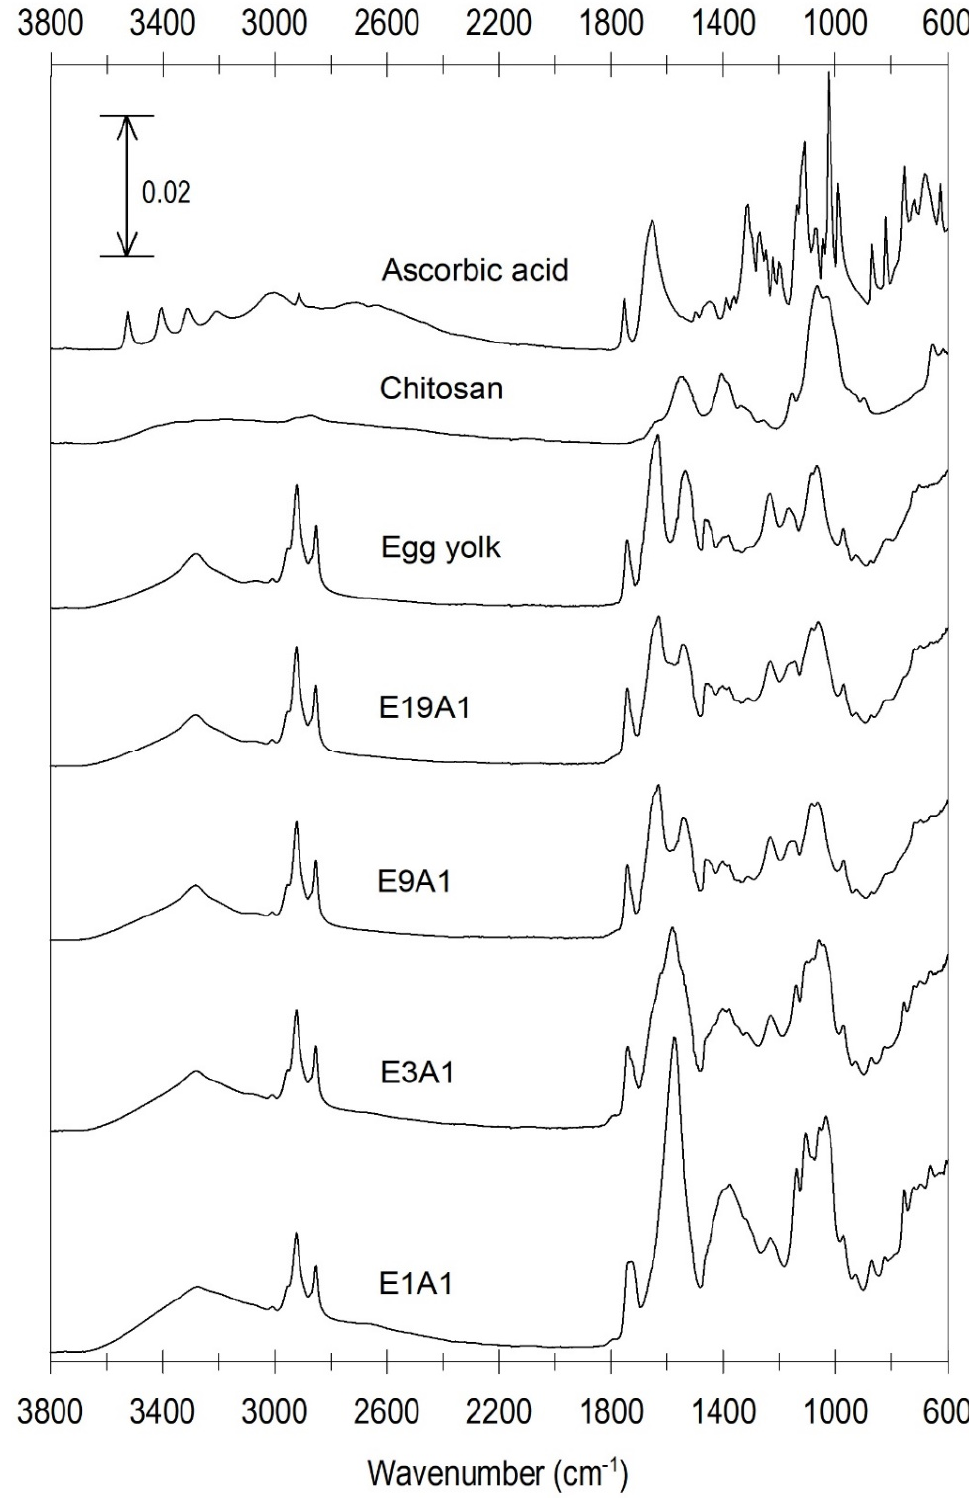
Figure 3. FT–IR spectrograms of ascorbic acid, chitosan, egg yolk and microcapsules E19A1, E9A1, E3A1 and E1A1. The FT–IR spectra were recorded from 3800 to 600 cm − 1 at a resolution of 4.5 cm − 1 by 32 scans.